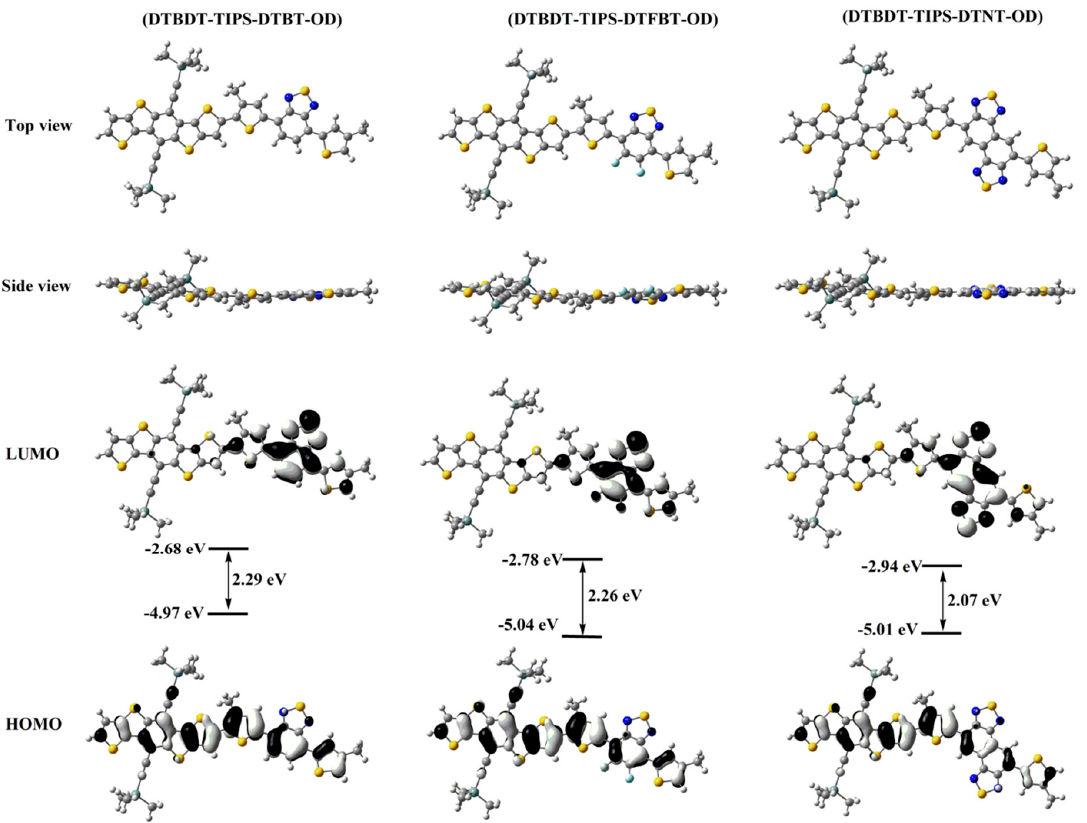
Figure 6. Caption optimized geometries and molecular orbital surfaces of the HOMO and LUMO for